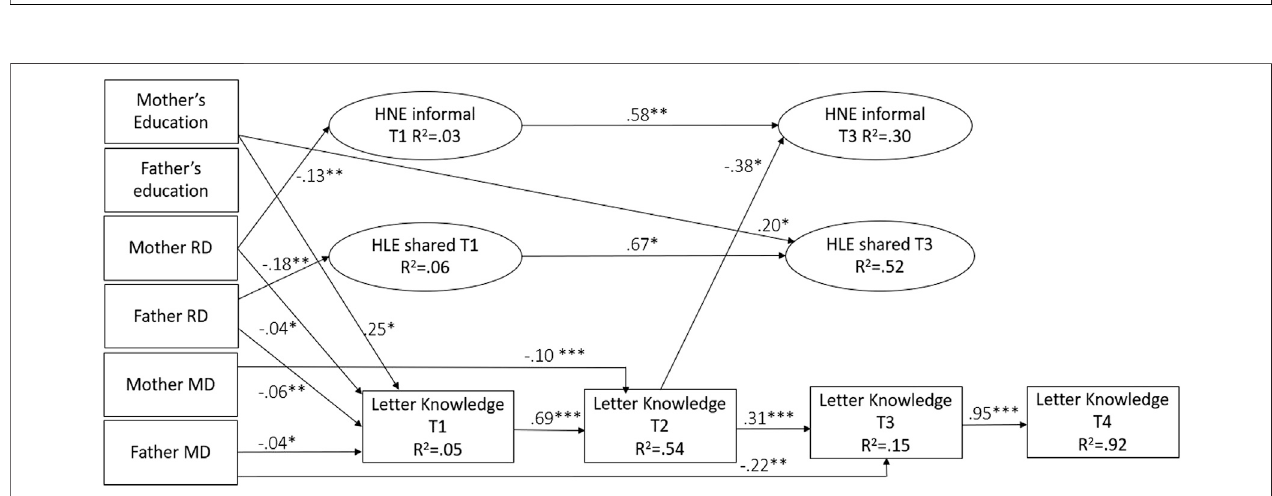
FIGURE 11 | The model for letter knowledge with the signi fi cant standardized estimates. Note: In addition to the regression paths depicted, there were two signi fi cant residual correlations: between HNE and HLE at T1 (stand. estimate (cid:1) 0.42***) and between HNE and letter knowledge at T1 (stand. estimate (cid:1) 0.49**).